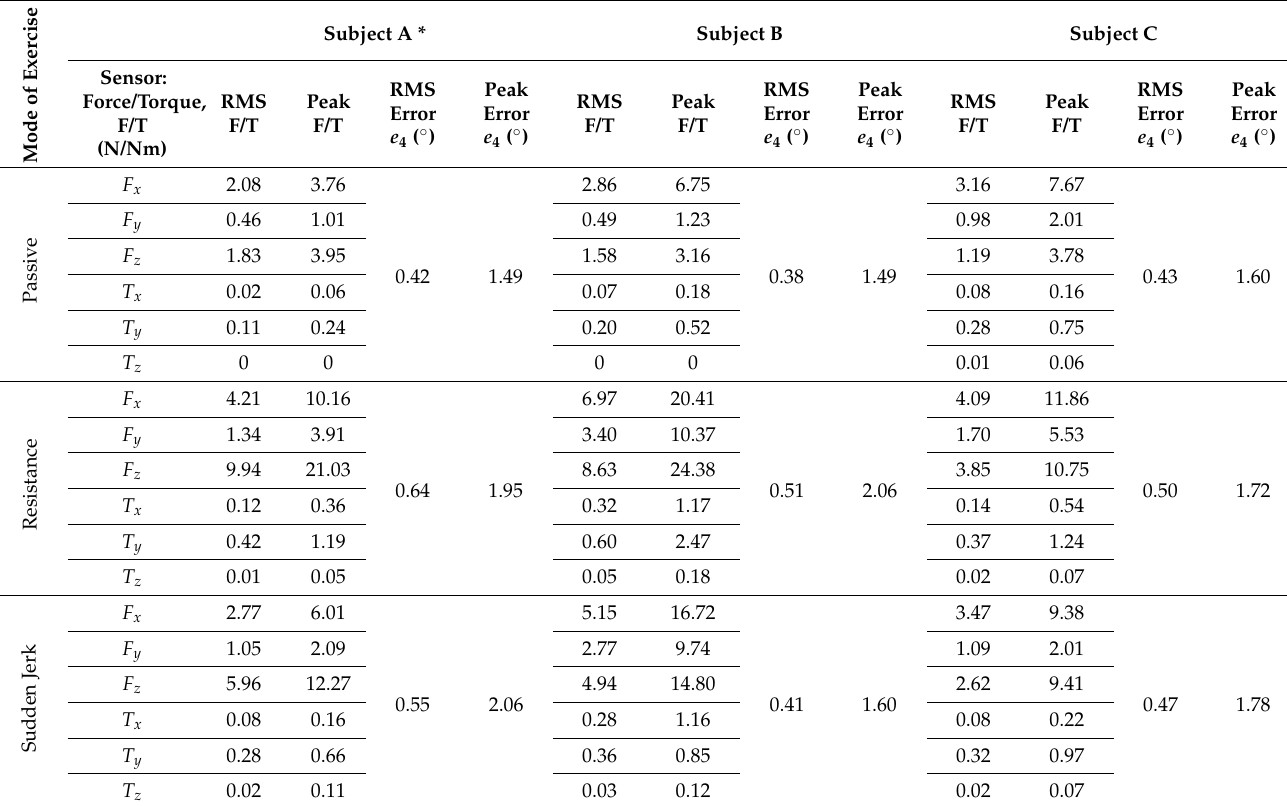
Table 5. Joint 4: Elbow flexion/extension passive